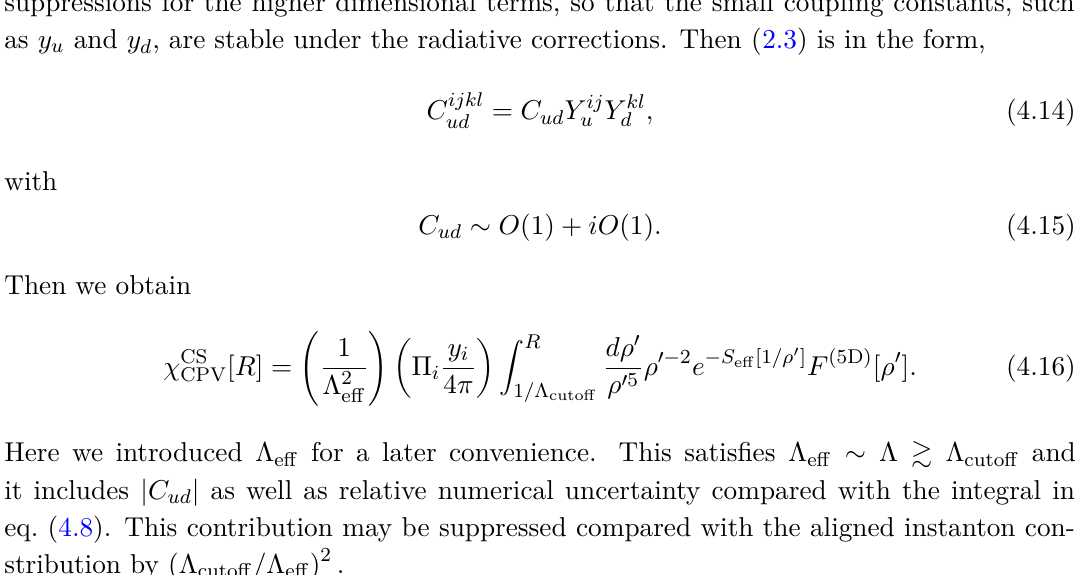
and Λ = Λ cutoff . The red solid pl / ( χ 0 + χ aligned ) ). The EDM bound (gray region) CPV